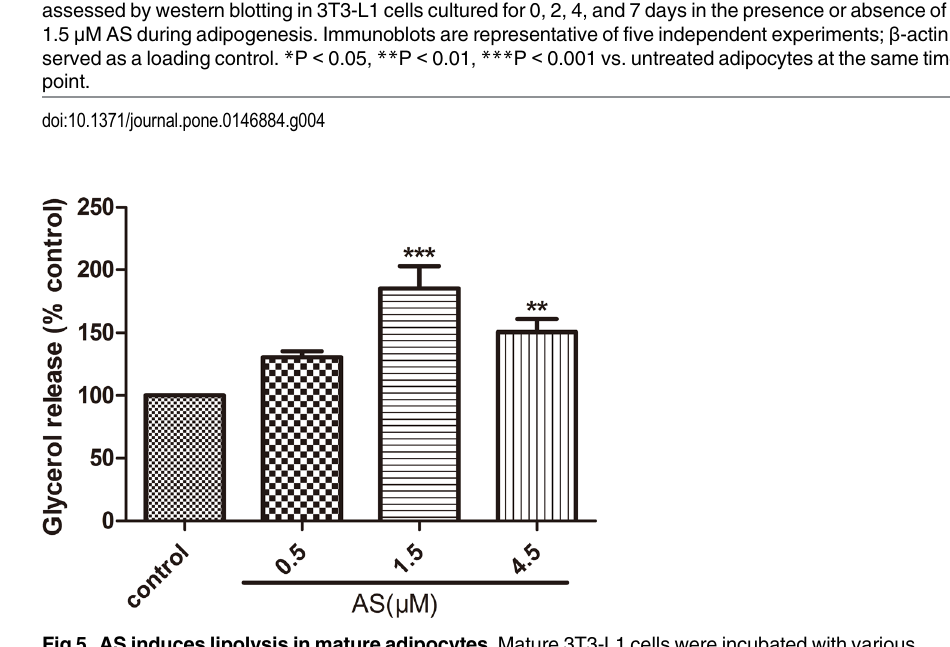
Fig 5. AS induces lipolysis in mature adipocytes. Mature 3T3-L1 cells were incubated with various concentrations of AS (0, 0.5, 1.5, and 4.5 μ M) for 24 h. Values are expressed as mean amount ( ± SE) of glycerol released per well as a percentage of the control value. Four replicates were carried out for each treatment. Means denoted with a different letter are significantly different (P < 0.05).